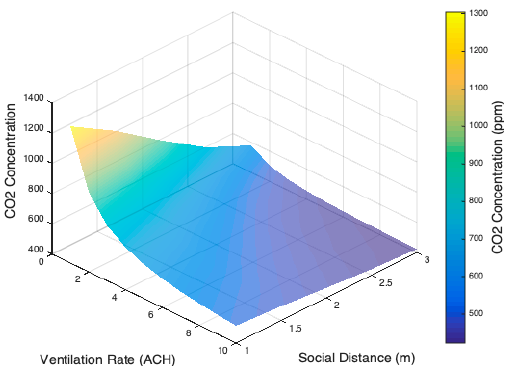
Figure 11. Impacts of MV ventilation rate and social distance on the indoor CO 2 concentration for July 22 nd .